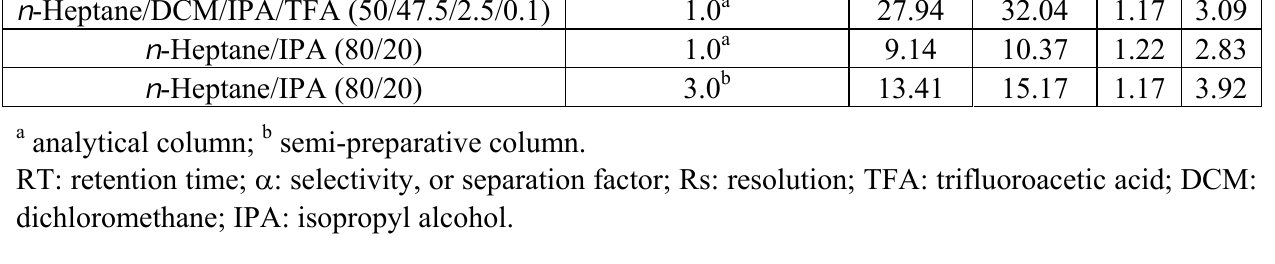
Figure 1. Separation of equol enantiomers on Chiralpak® IA stationary